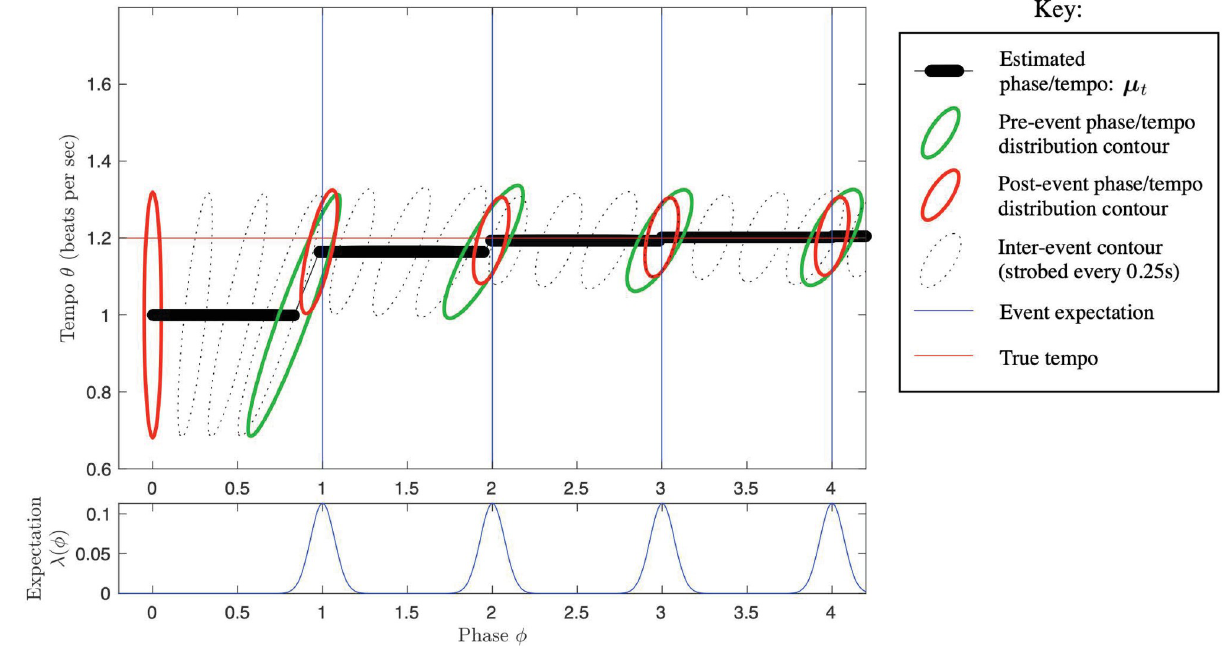
Fig 5. The PATIPPET filter estimates phase and tempo. PATIPPET is initialized with high tempo uncertainty. The first event occurs relatively early, causing the estimated tempo to increase. Each subsequent event occurs close to the time expected based on the estimated phase and tempo, causing the posterior to contract in both the phase and tempo direction as its prediction of event time is fulfilled and its phase and tempo estimates are corroborated. Ultimately, PATIPPET settles on a narrow distribution around the appropriate tempo as it continues to accurately estimate phase.